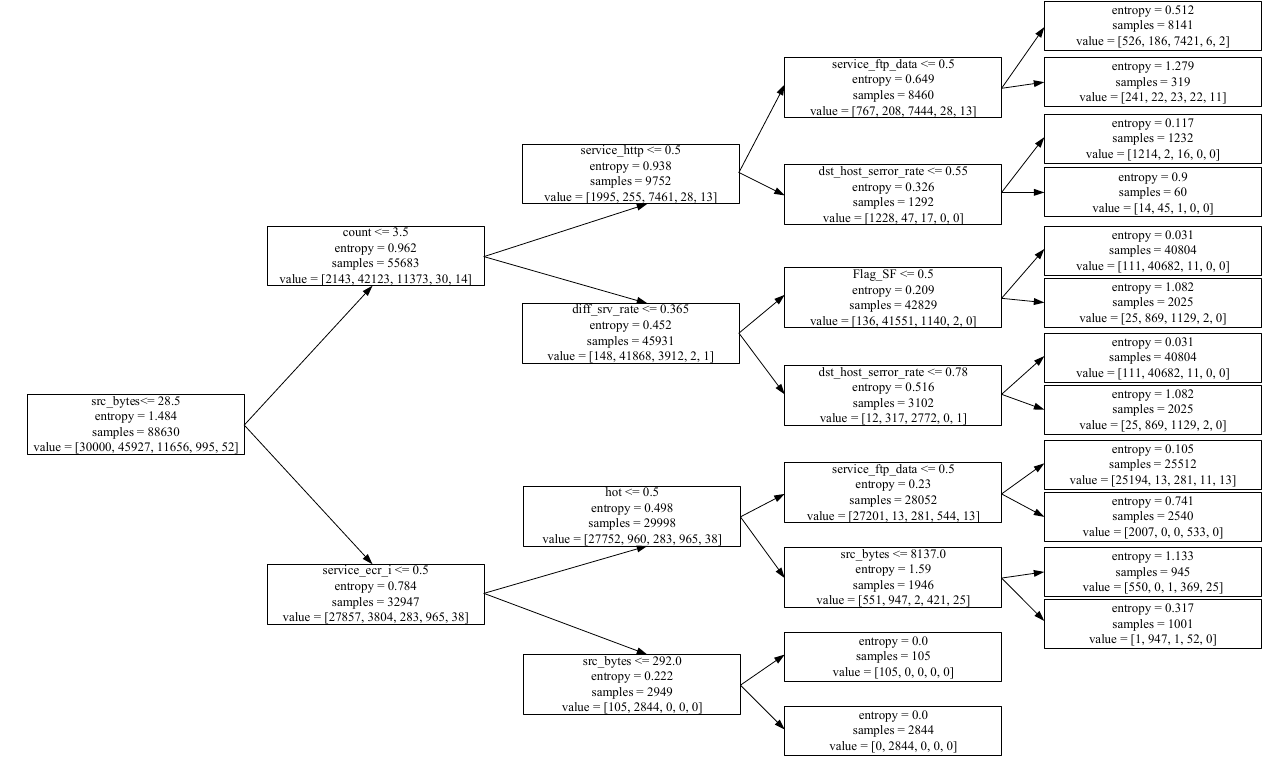
Figure 3. 4-level binary decision tree model.